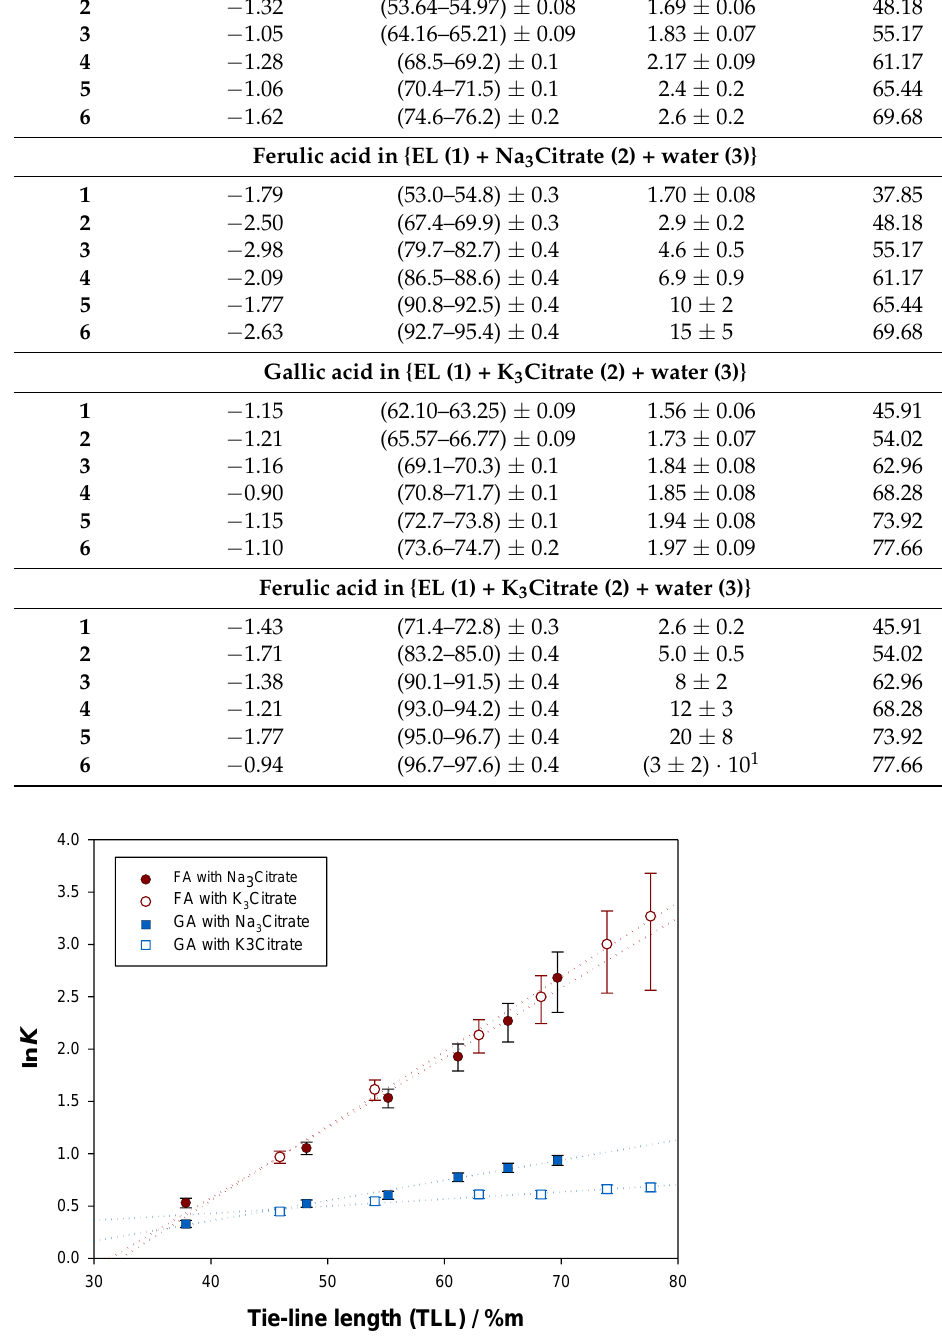
Figure 4. Relation between the natural logarithms of the experimental partition coefficients ( 𝐾 ) and the tie-line lengths (TLL) for gallic acid (GA) and ferulic acid (FA) in the ATPS {ethyl lactate (1) + trisodium citrate (2) + water (3)} and {ethyl lactate (1) + tripotassium citrate (2) + water (3)} at 298.15 K and 0.1 MPa.